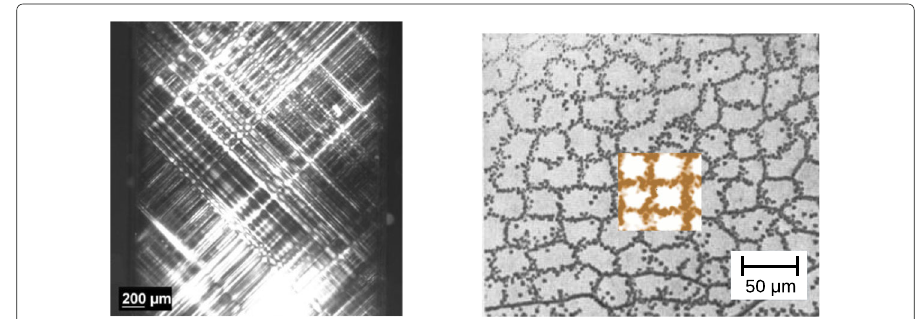
Fig. 7 Cell structures in LiF; top: birefringerence image of the (001) surface of a (100) oriented single crystal showing slip activity on the orthogonal ( 1 ¯ 10 ) [110] and ( 110 ) [1 ¯ 10] slip systems, courtesy of J. Schwerdtfeger; bottom: etch pit pattern on a (100) cross section after deformation under a creep load of σ = 5.9 MPa ( τ = 2.45 MPa) to a creep strain of (cid:17) p = 0.05 ( γ = 0.1), deformation temperature 773K, averaged dislocation density ρ = 3 × 10 11 m − 2 (Streb and Reppich 1973); the insert has been taken from the simulation shown in Fig. 3 and scaled according to the average dislocation density in the experimental